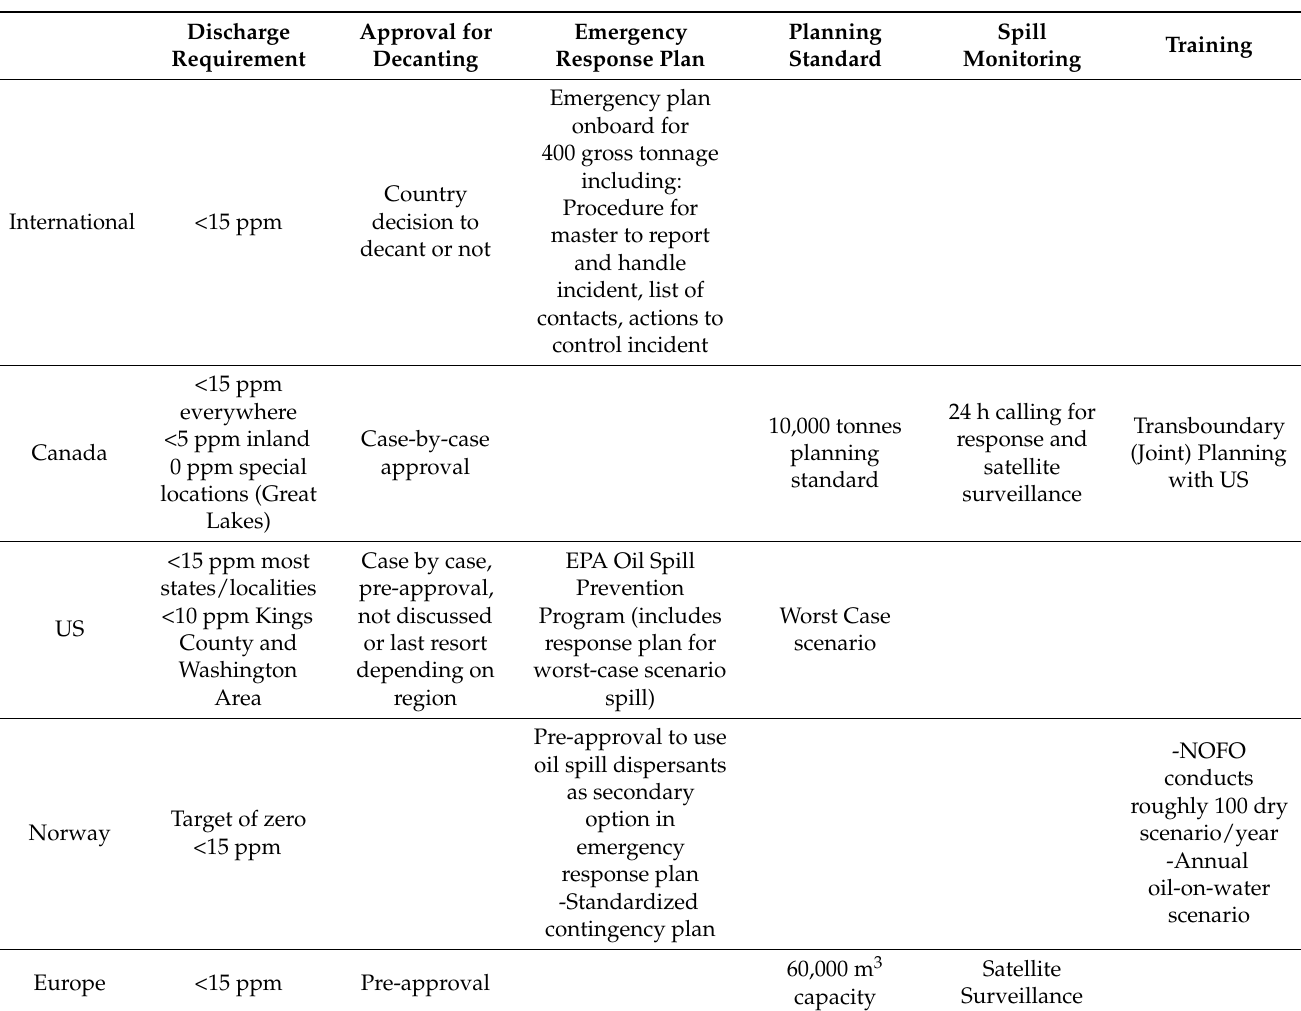
Table 4. Regulatory Gap